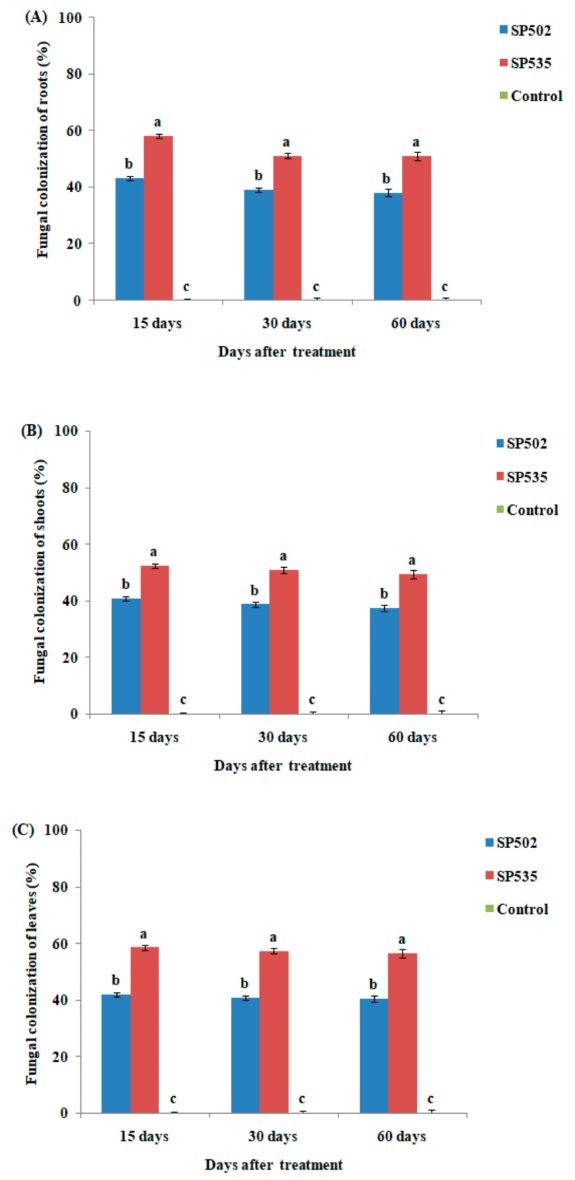
Figure 4. Percent colonization of di ff erent plant parts by Cordyceps fumosorosea isolates after 30 days, 45 days and 60 days of fungal treatment. ( A ) Roots; ( B ) shoot; and ( C ) leaves. Error bars indicate the standard error of means based on five replicates (n = 5). Bars having di ff erent letters indicate that means are significantly di ff erent from each other at 5% level of